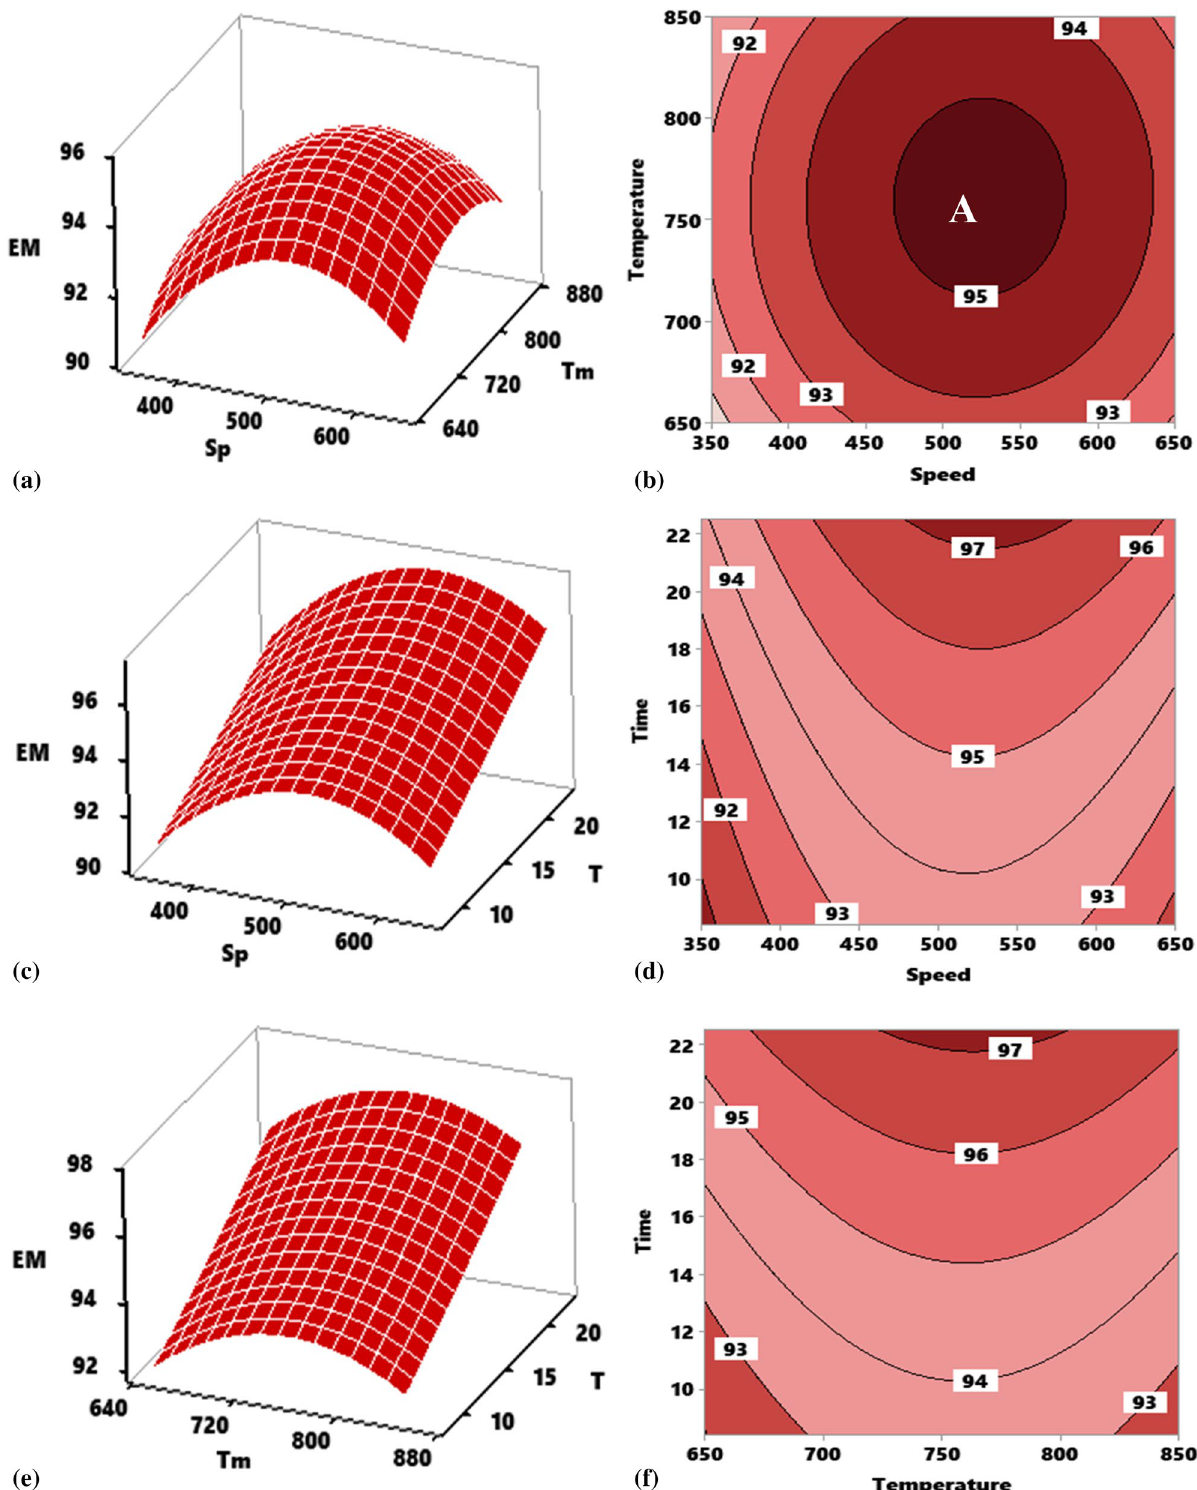
Figure 6. Influence of stirring parameter on elastic modulus of developed composite as represented by response surface plot and contour plot for interactions. ( a , b ) Speed and temperature, ( c , d ) speed and time, ( e , f ) temperature and